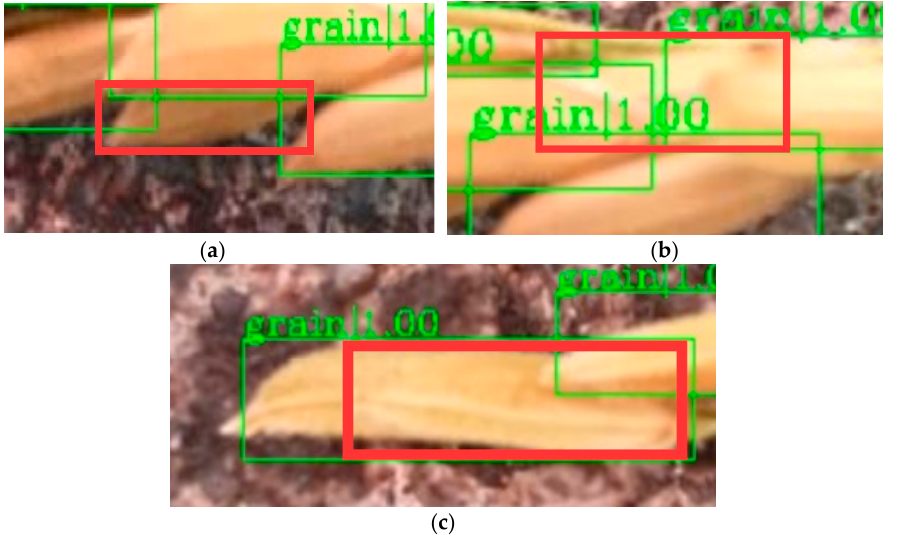
Figure 7. Examples of images causing grain detection errors: ( a ) most area of the grain was covered and blurred; ( b ) most area of the grain was covered and under lighting reflection; ( c ) two bonded grains under light reflection.